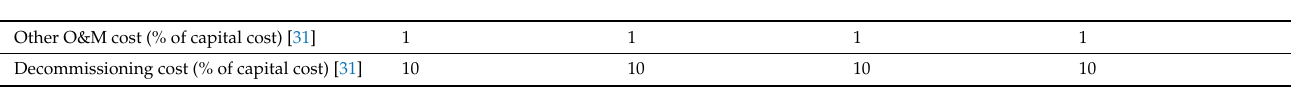
Davis-Besse NPP in Ohio of Energy Harbor, which uses LTE for hydrogen production.